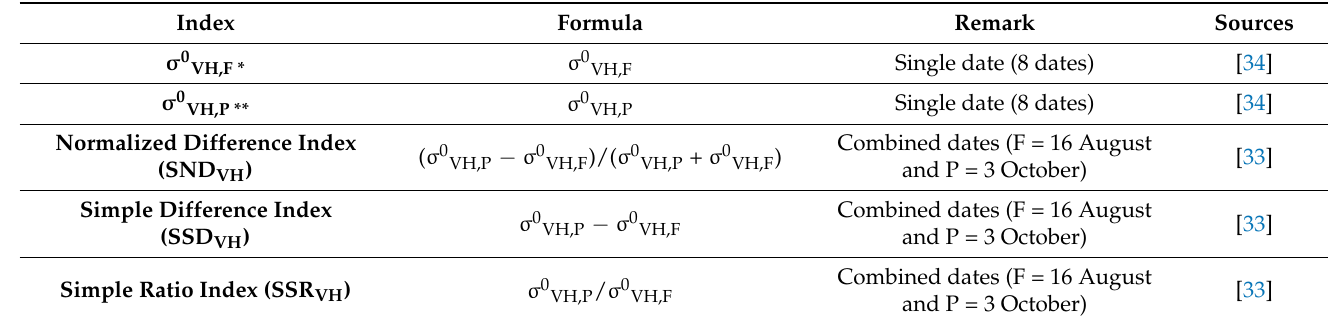
Table 2. The five types of SAR indices used in this study.